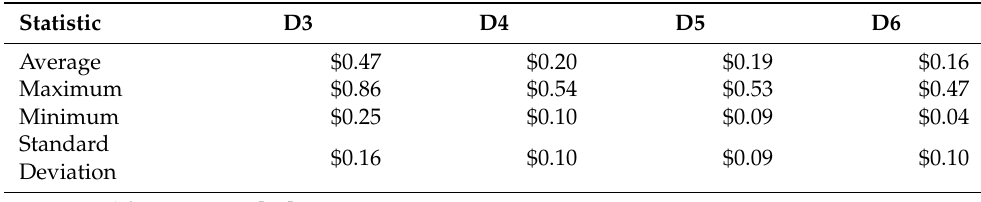
Table 2. Average maximum, minimum, and standard deviation of renewable identification number (RIN) prices in 2020 for D3, D4, D5, and D6 products